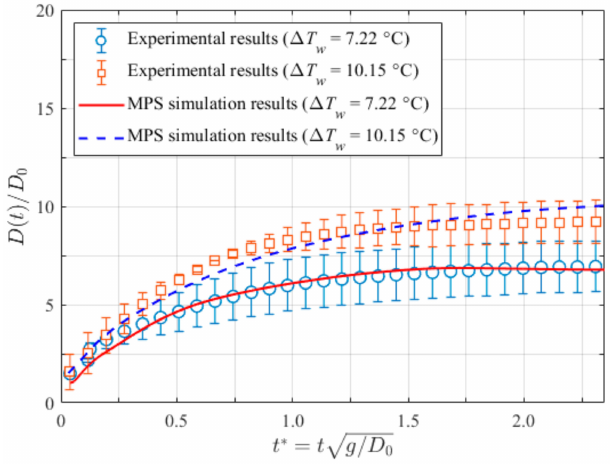
Figure 11. Comparison of the bubble diameter variation between numerical simulations and experi- ments on the ITO heater.